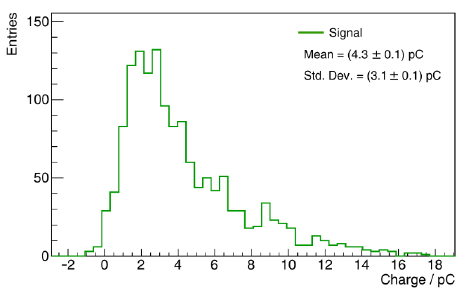
Figure 5. Example of a single muon charge histogram used to calibrate the integrated signal mode.